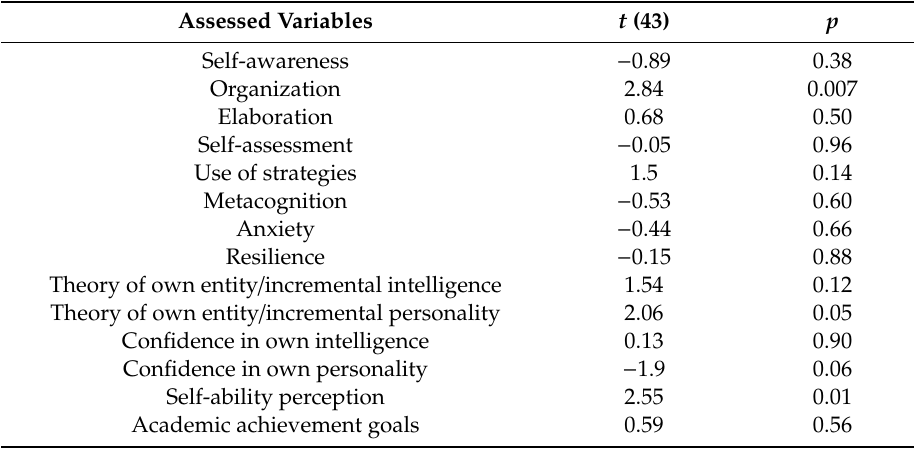
Table 2. Preliminary analysis.